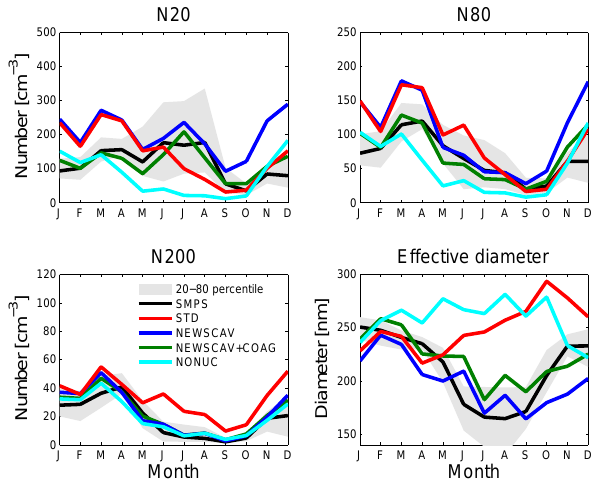
Figure 6. Monthly median number concentration for aerosols with diameters of 20–500nm (N20), 80–500nm (N80), and 200–500nm (N200) and effective diameter from the 2011-2013 Mt. Zeppelin DMPS measurements and for the four GEOS-Chem-TOMAS dry size distribution simulations described in Table 1. The measure- ment 20–80th percentile is in grey shading. Simulations are shown in colour as indicated by